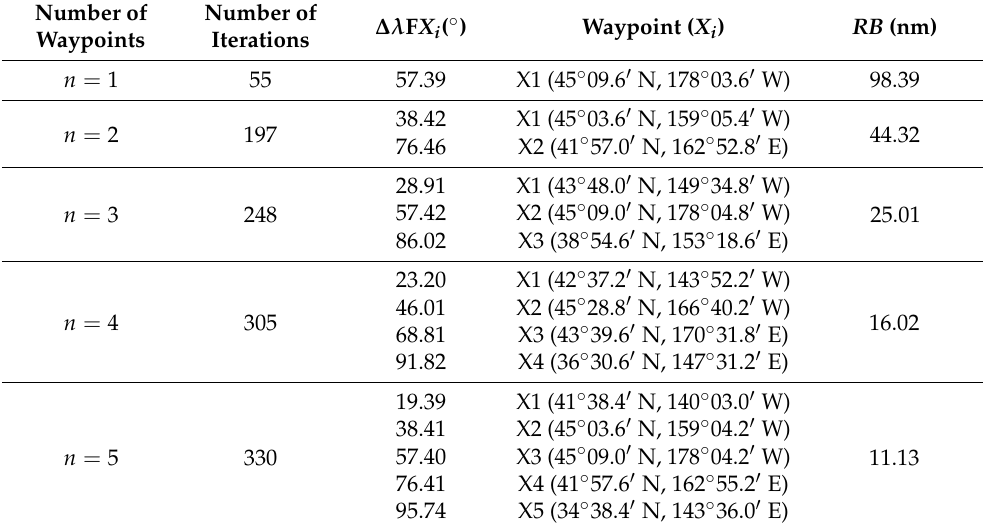
Table 2. Using the GA method to optimize the